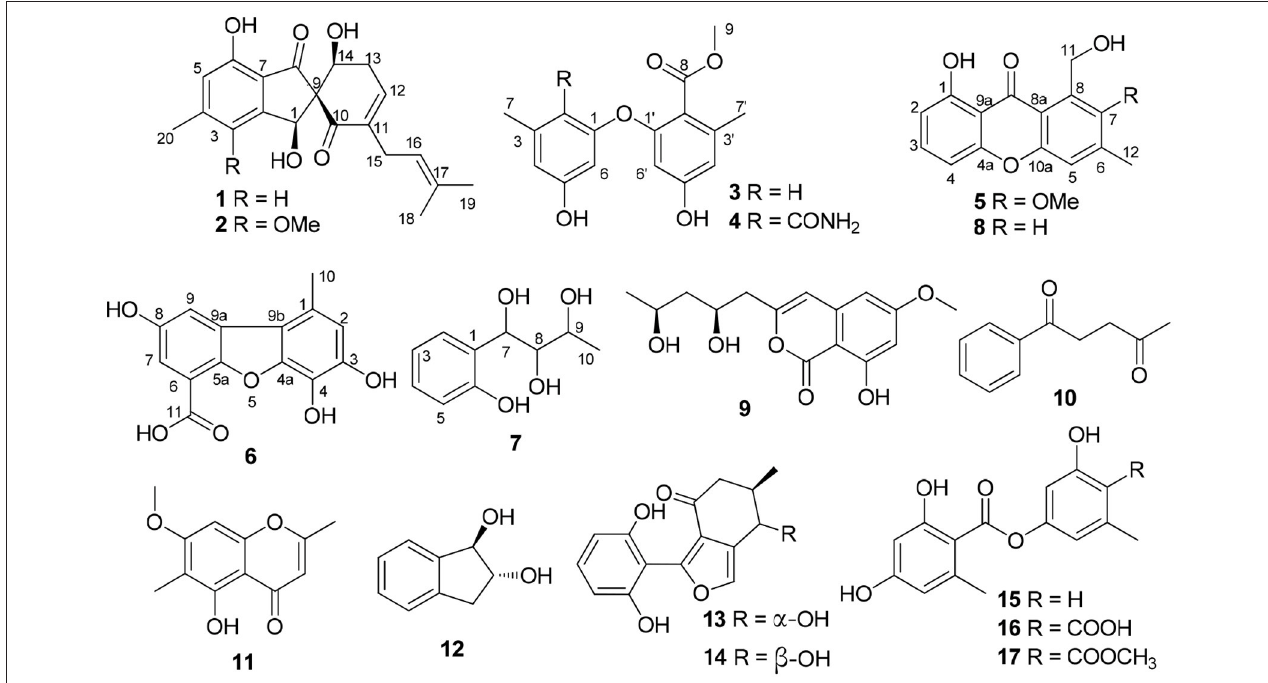
FIGURE 1 | Structures of 1 – 17